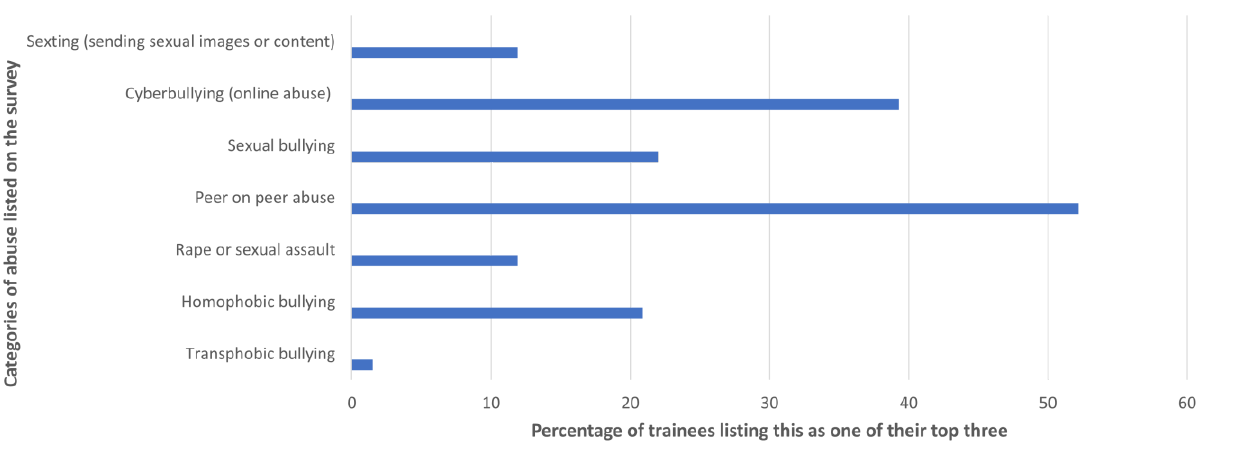
Figure 1. Professionals’ Concerns Regarding Violence in the Lives of the Young People They Figure 1. Profes sionals’ Concerns Regarding Violence in the Lives of the Young People They Worked Worked With.